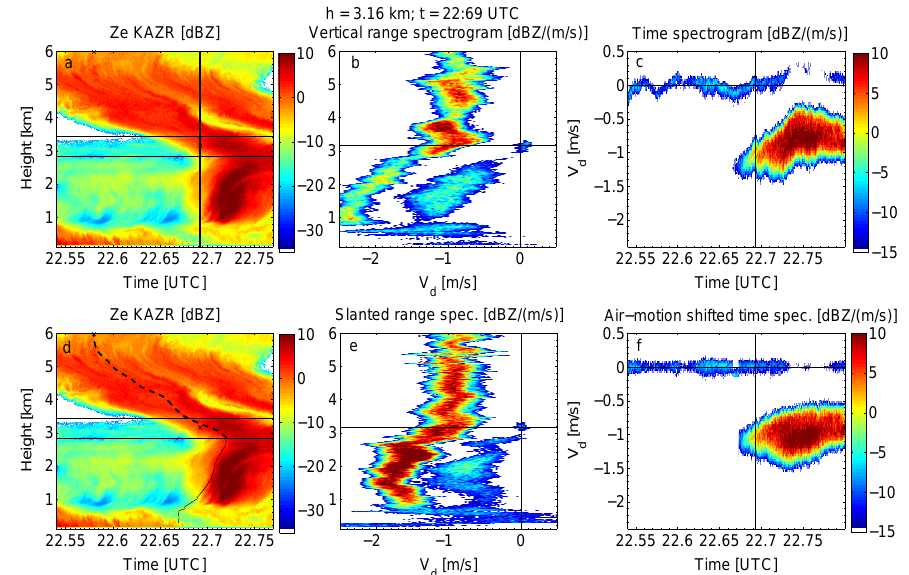
Figure 6. Panels (a, d) show KAZR reflectivity (Ze) field. There, the location of the SLW layer is indicated by thin horizontal black lines. The upper middle and upper right panels show range and time spectrograms of vertical profile which is indicated by a black vertical line in (a) ; the lower middle and lower right panels along slanted fall streak are shown in (d) as a dashed line. Panel (b) shows vertical range spectrogram along vertical black line in upper left panel, (c) time spectrogram at 3.16km, (e) slanted range spectrogram along dashed line in (d) . Panel (f) shows the air-motion-corrected time spectrogram at